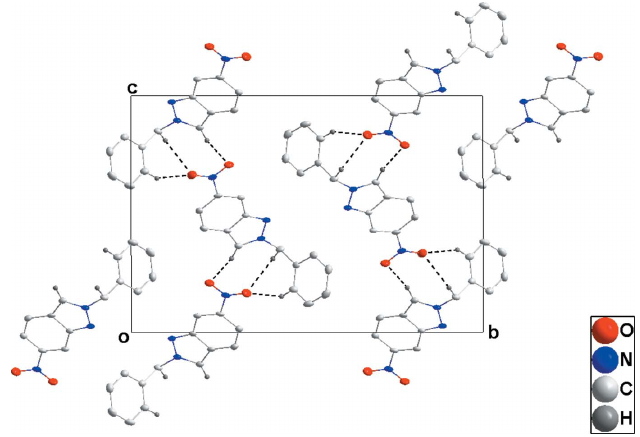
Figure 3 Packing, viewed along the a -axis direction, with C—H (cid:3)(cid:3)(cid:3) O hydrogen bonds shown as black dashed lines.